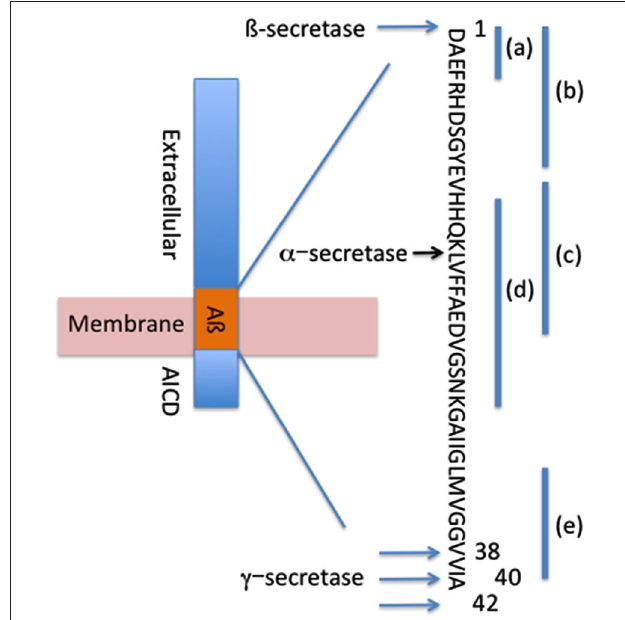
FIGURE 1 | Systematic processing of APP forms A β 42 , A β 40 and A β 38 . Locations of β -secretase, α -secretase and γ -secretase cleavage sites are depicted. Binding sites for passive antibodies are identified as (a)—Bapineuzumab, (b)—Gantenerumab, (c)–Crenezumab, (d)—Solanezumab,